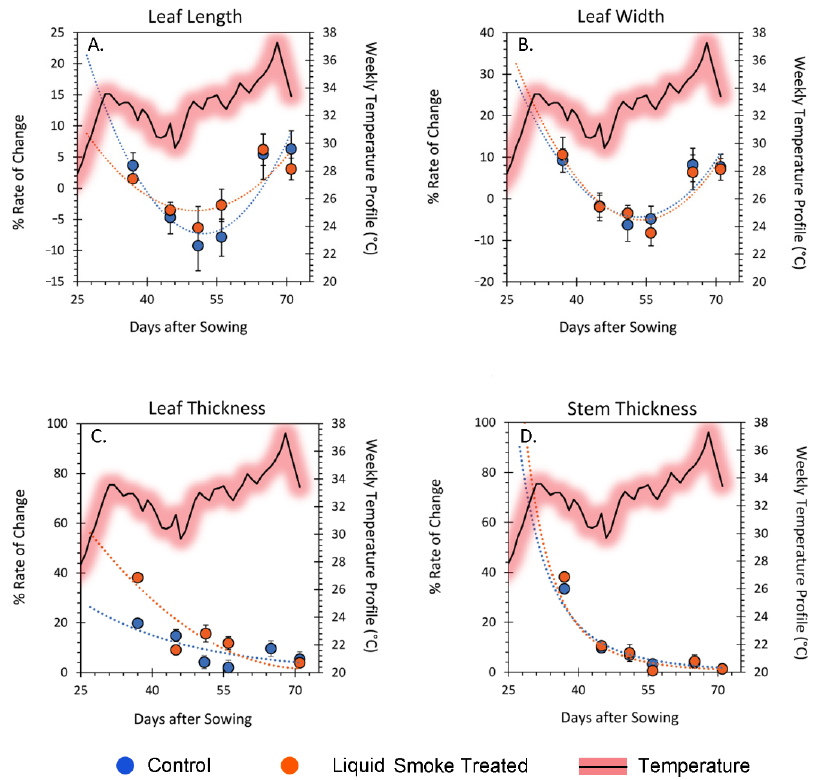
Figure 8. Relative change in plant growth for outdoor potted plants. Panel ( A ): relative change in leaf length growth. Panel ( B ): relative change in leaf width. Panel ( C ): relative change in leaf thickness. Panel ( D ): relative change in stem thickness. Each data point represents average values ± PE (propagated error) for control, N = 22 plants, and liquid smoke-treated, N = 23 plants. Data were fit to best trends shown in each panel as the dashed lines. Each panel also shows the temperature trend over the growing season for the 5 ‐ day average of temperature highs.